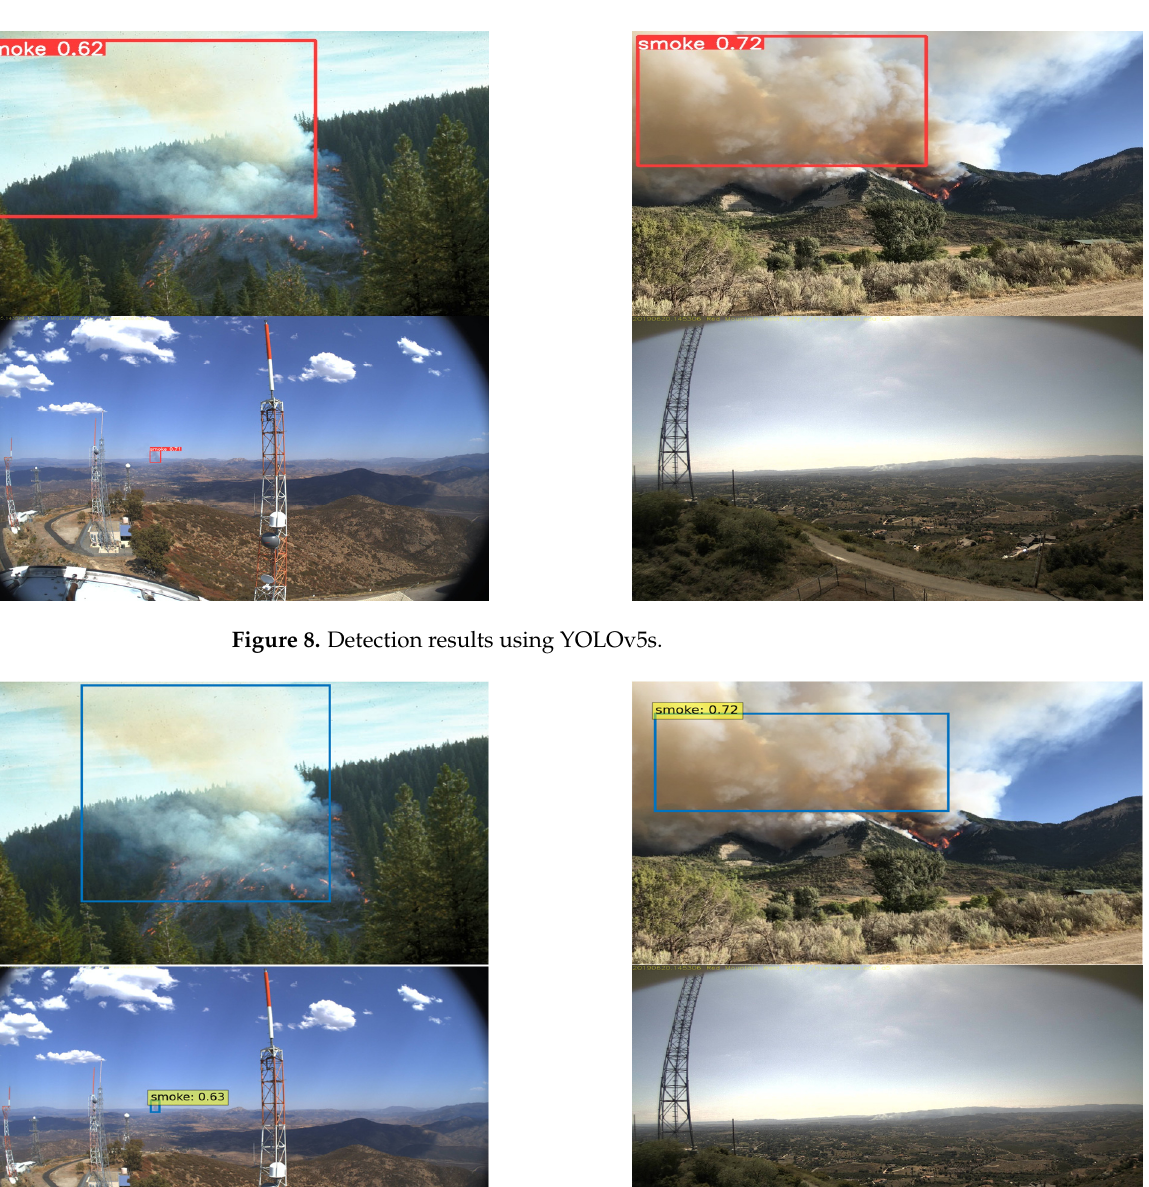
Figure 7. Detection results of our improved deformable DETR model. The first row shows small- target smoke images, the second row shows large-target smoke images.